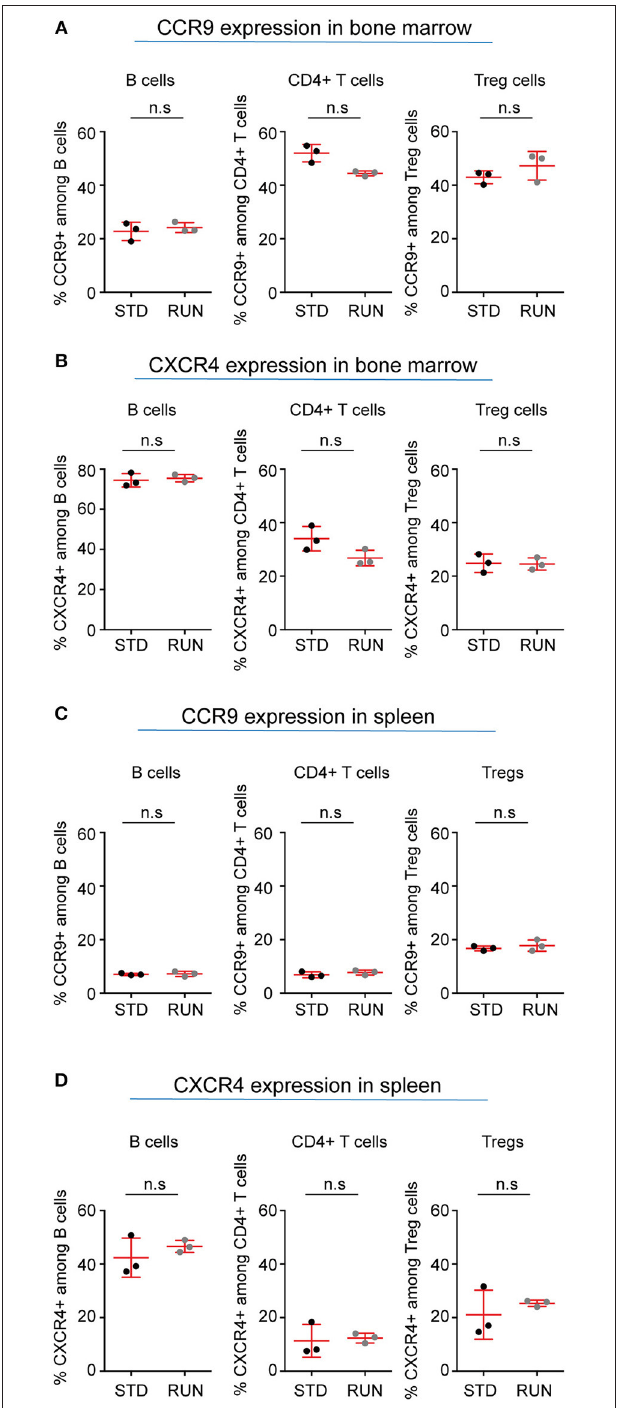
FIGURE 8 | Expression of selected chemokine receptors on B cells, CD4 + T cells and Tregs in the bone marrow and spleen of STD and RUN mice. Composite percentages of (A) CCR9 and (B) CXCR4 expression on the indicated cell population in the bone marrow. Composite percentages of (C) CCR9 and (D) CXCR4 expression on the indicated cell populations in the spleen. Symbols and horizontal lines indicate individual mice and mean values, respectively. Data are representative of two independent experiments. Data were analyzed using a two-tailed Mann Whitney